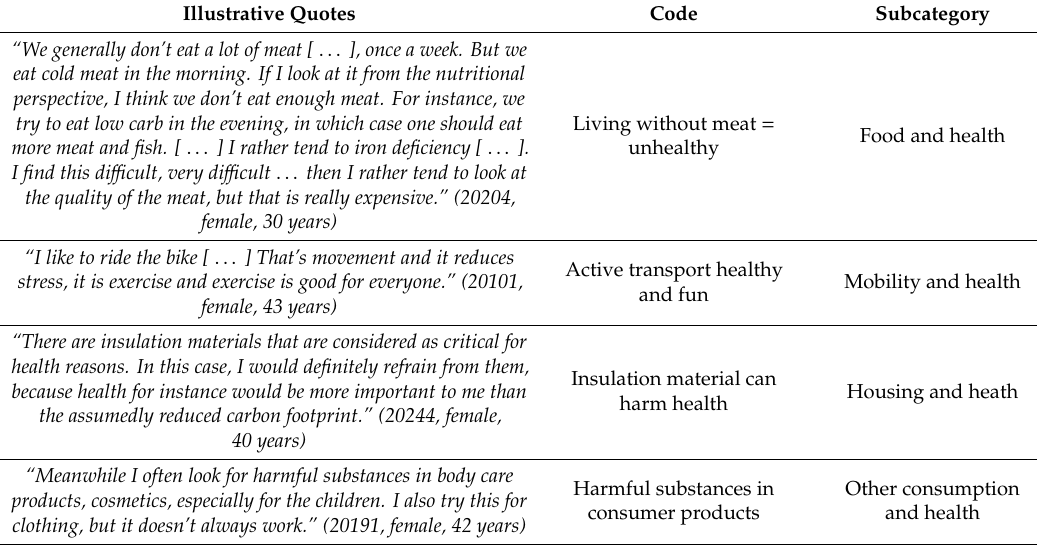
Table 4. Illustrative quotes on health perceptions of climate change mitigation